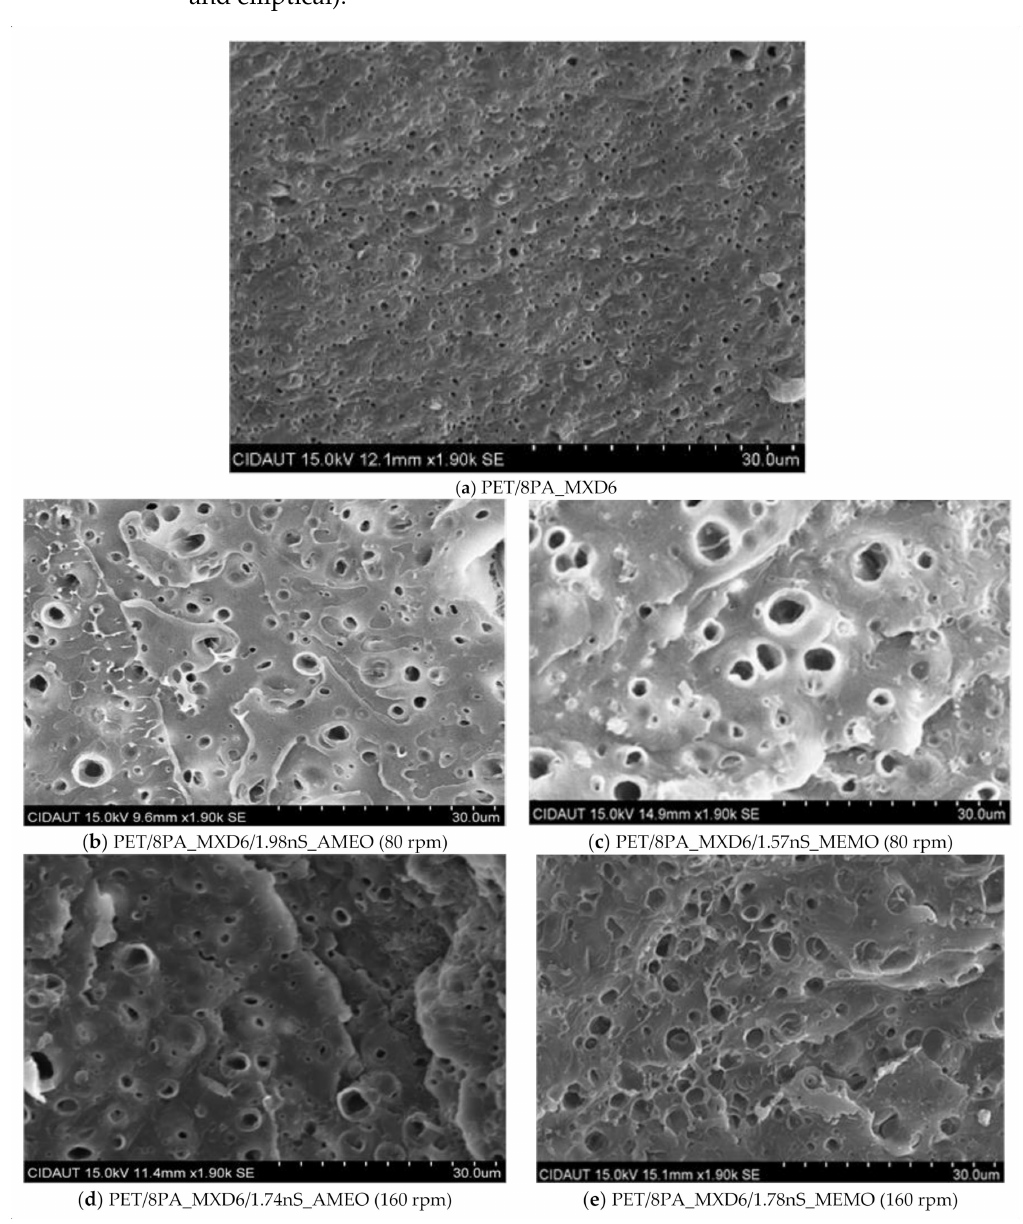
Figure 4. SEM pictures of PET/PA and PET/PA/nS samples with different nanosepiolite